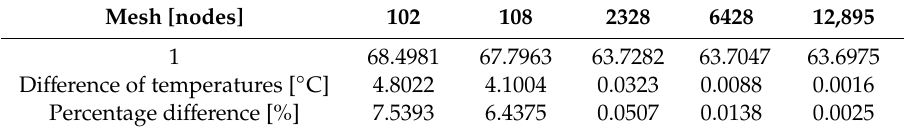
Table 5. Temperature at a point of the tube with two conductivities using [ M τ ] . Mesh [nodes] 102